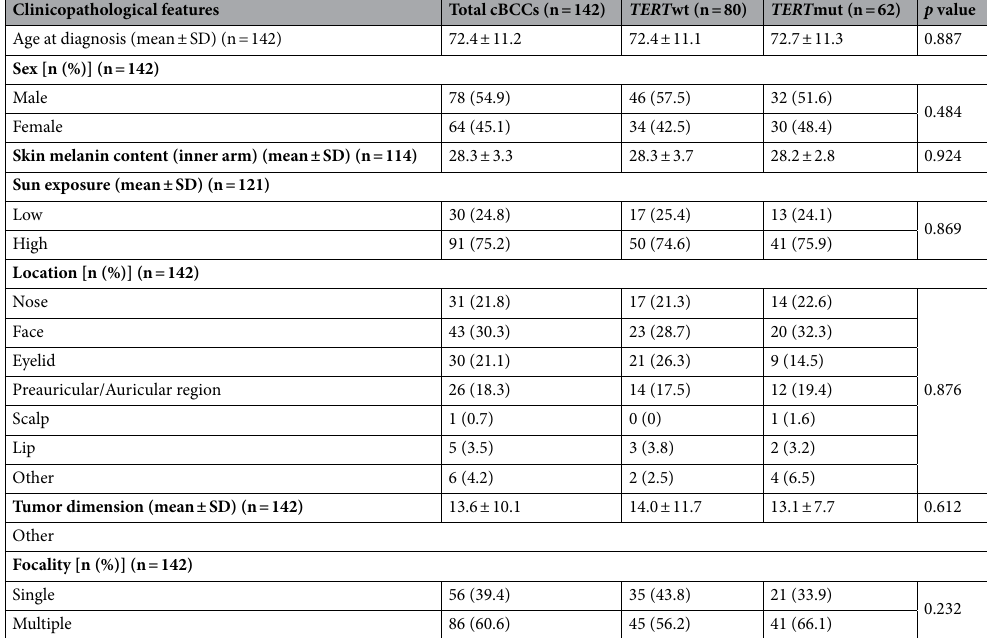
Table 3. Clinicopathological features in cBCCs and TERTp mutation status.